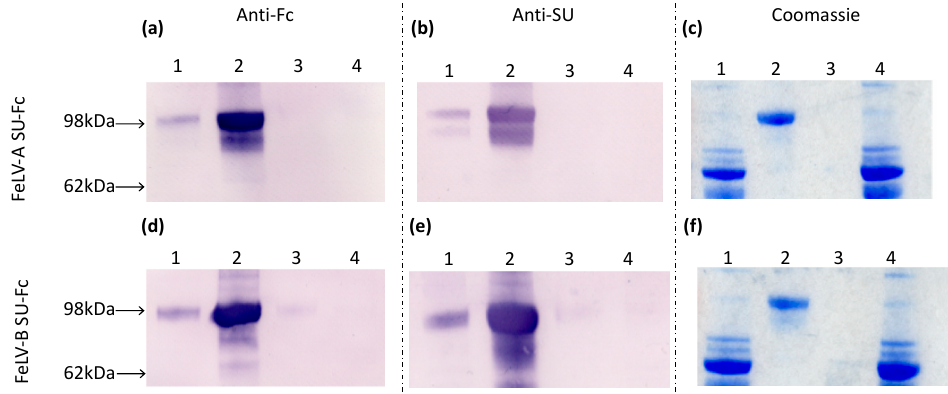
Figure 2. Culture fluids were collected at the following stages of protein purification: (1) pre-purification, (2) post-purification, (3) PBS wash-through and (4) ultrafiltrate waste. In immunoblot analysis of samples from the FeLV-A and FeLV-B SU purification, membranes were probed with either anti-Fc antibody ( a and d , respectively) or anti-SU antibody ( b and e , respectively), while gels were stained with Coomassie blue ( c and f , respectively).